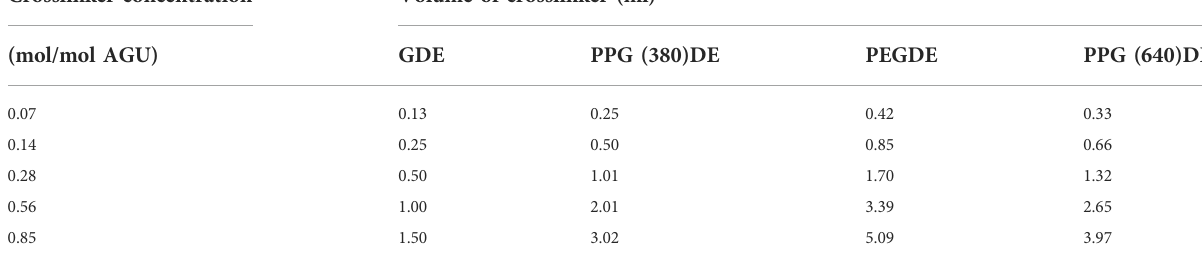
TABLE 2 Volumes of crosslinker added to 2.5 g of CMC in each replicate for the synthesis of the each CMC-DE fi lm. Crosslinker